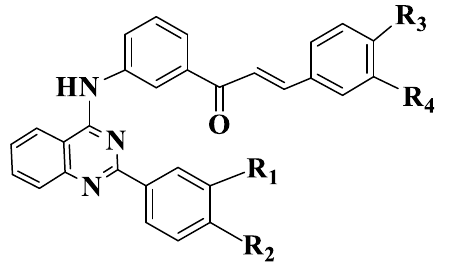
Figure 5. General structure of quinazoline chalcones (compounds 66 – 71 ).